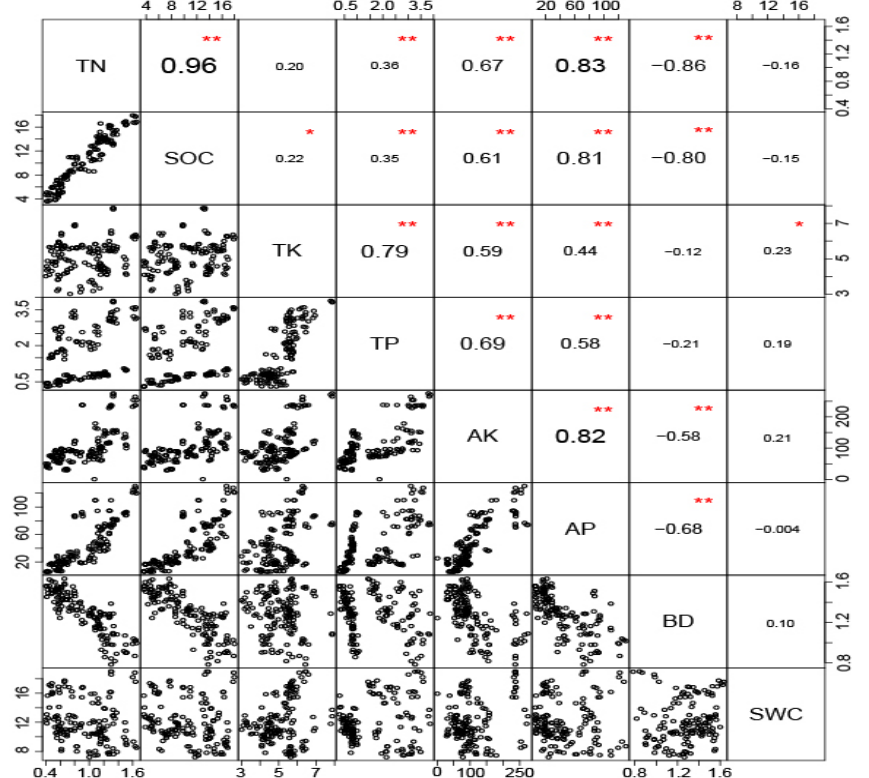
Figure 2. Correlation coefficients among soil properties in the 0–40 cm layer. The bottom left part of the matrix shows scatter plots of soil properties; the upper right section shows correlation coefficients; number size indicates levels of correlation; * p < 0.05; ** p < 0.01. TN, total nitrogen; SOC, soil organic carbon; TK, total potassium; TP, total phosphorus; AK, available potassium; AP, available phosphorus; BD, soil bulk density; SWC, soil water